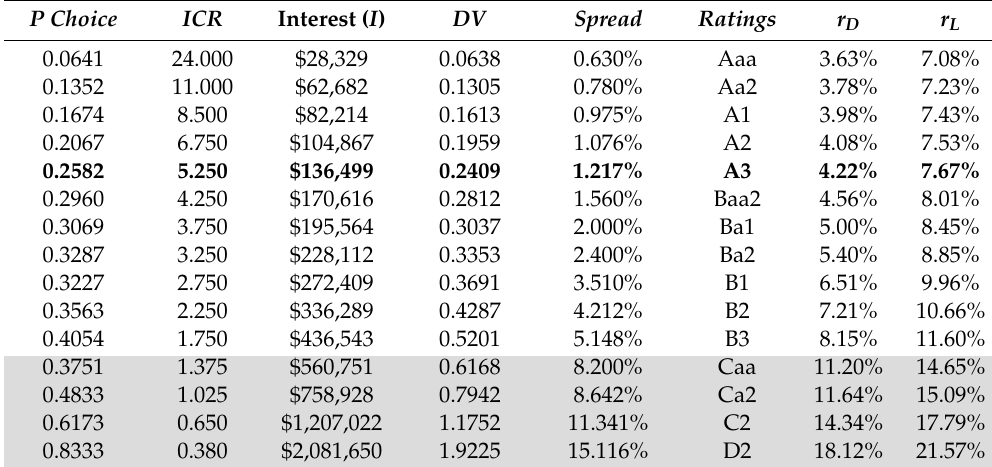
Table 1. Costs of